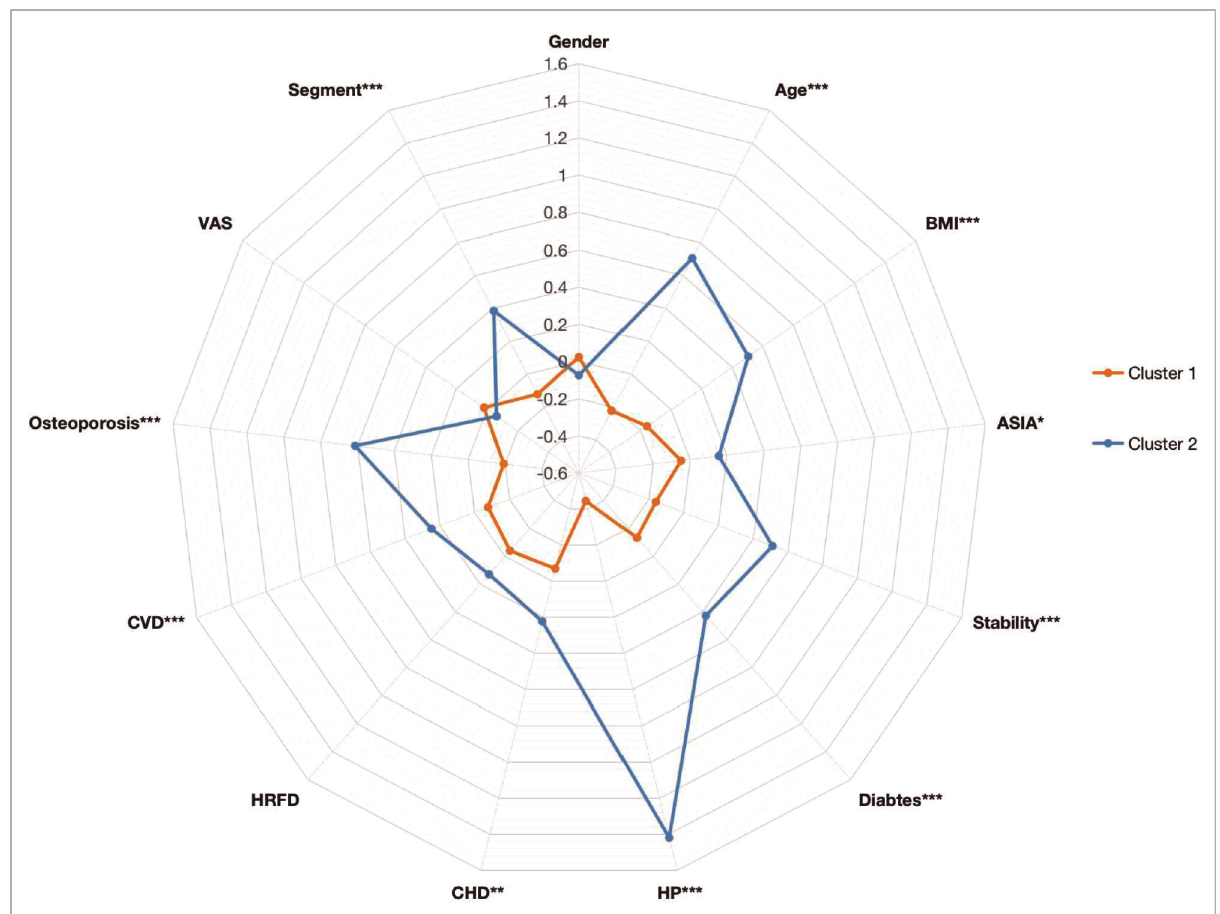
FIGURE 4 Radargram of 13 preoperative variables in cervical spondylotic myelopathy patients in two clusters. The K-means clustering algorithm normalized preoperative variables were compared between two clusters. Spoke lengths represent the average of each variable after the K-means clustering algorithm is normalized. Signi fi cance levels are presented with asterisks. BMI: body mass index; ASIA: American Spinal Cord Injury Association; HP: hypertension; CHD: cardiovascular heart disease; CVD: cerebrovascular disease; VAS: visual analog scale; HRFD: hepatic and renal function disorder. * p -value <0.05, ** p -value <0.01, *** p -value